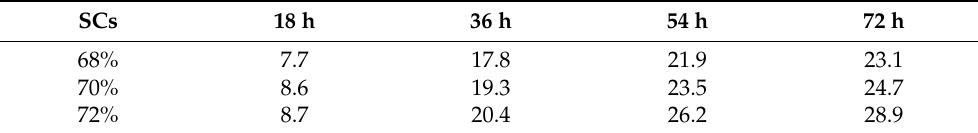
Table 5. Total heat release Q (J/g) under different SCs.